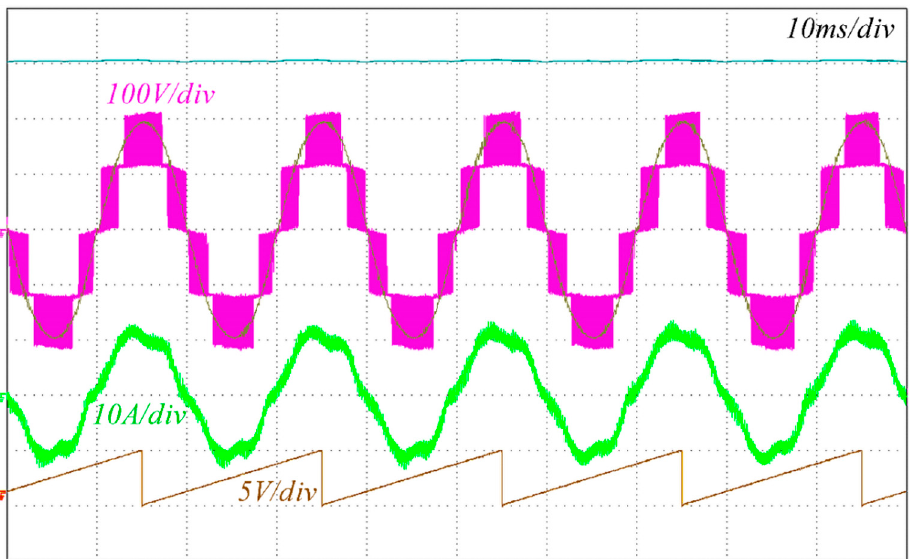
Figure 19. Flywheel side converter waveforms during charging: leg-to-neutral switching voltage u u1(sw) (magenta track) before the ICT, fundamental component (extracted), electrical machine phase currents (green track) and angular flux position (red track).